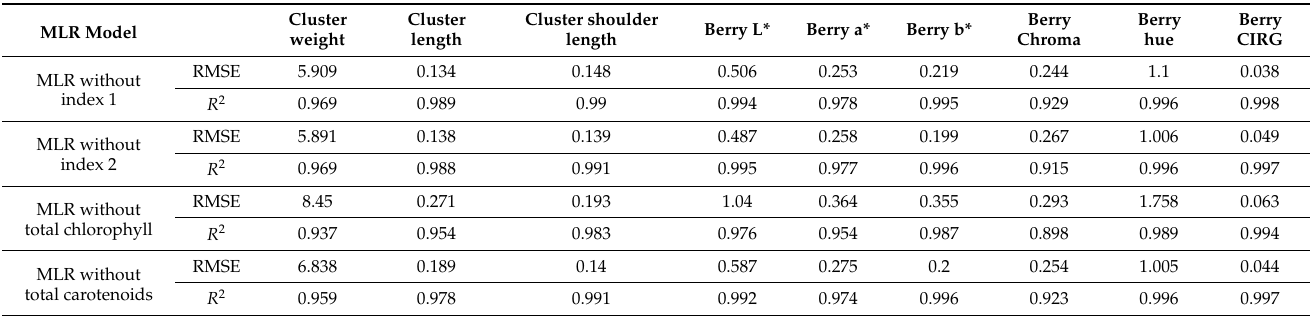
Table 9. The sensitivity analysis of the input parameters on cluster weight, cluster length, cluster shoulder length, berries L*, a*, b*, chroma, hue, and